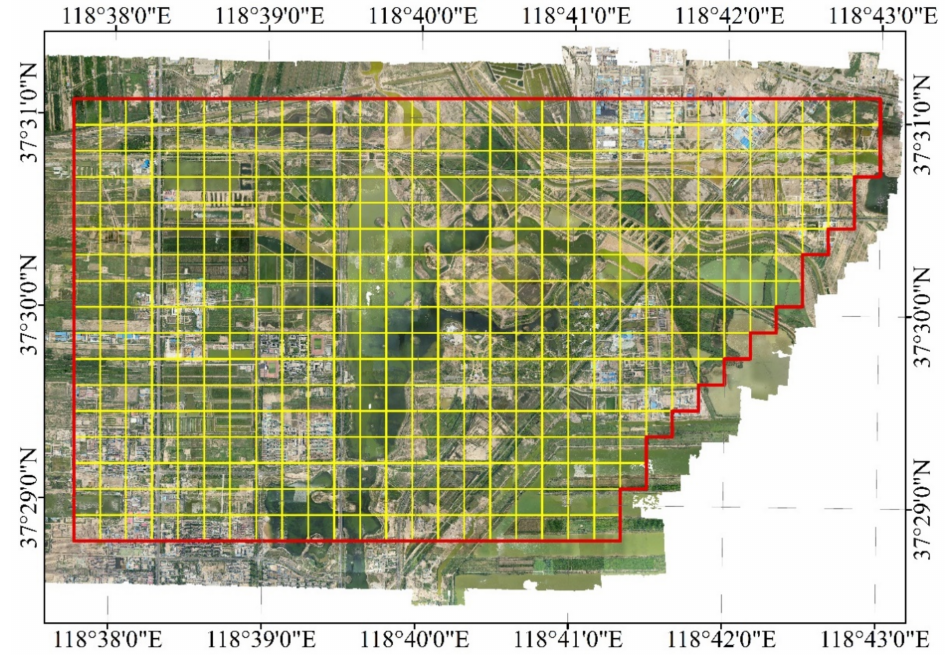
Figure 11. Experimental area and reconstruction